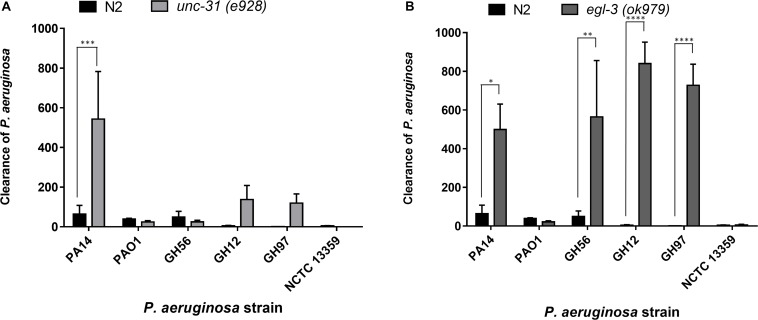
Clearance of P. aeruginosa strains from the C. elegans intestine is highly dependent on intact neuromodulation. The clearance of different strains of P. aeruginosa from the C. elegans intestine in unc-31 (e928)
(A) and egl-3 (ok979)
(B) mutant worms was measured using methods outlined in Figure 5. These experiments were performed in at least triplicate for all strains. Error bars represent ± SEM. Analysis is by one-way ANOVA with Sidaks multiple comparison. Significance relative to N2 worms is shown. ∗P < 0.05, ∗∗P < 0.01, ∗∗∗P < 0.001, ****P < 0.0001.